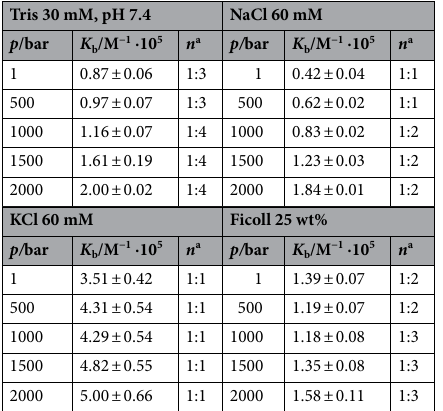
Table 3. Binding constants ( K b ) and stoichiometries for the 22AG:ThT complex formation in the indicated solutions and at pressures of 1, 500, 1000, 1500 and 2000 bar ( T = 25 °C. a n represents the stoichiometry of binding as